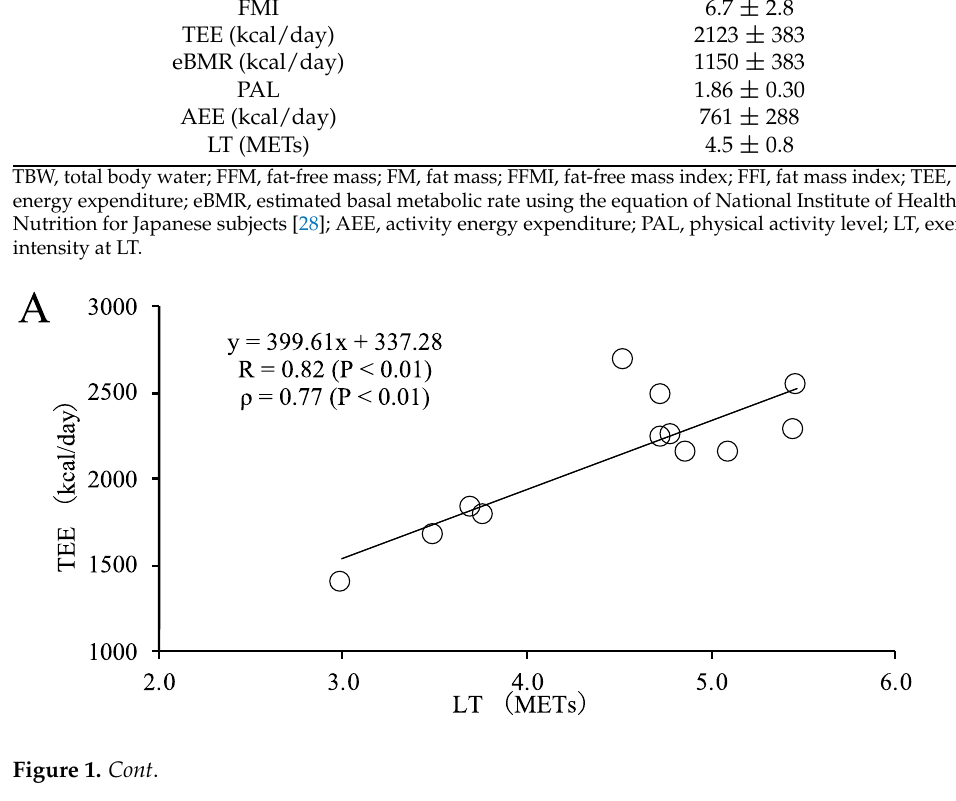
Figure 1. Relationship between LT and TEE ( A ), AEE ( B ), or PAL ( C ) r, Pearson’s correlation coefficients; ρ , Partial correlation coefficients after adjusting for sex and age.